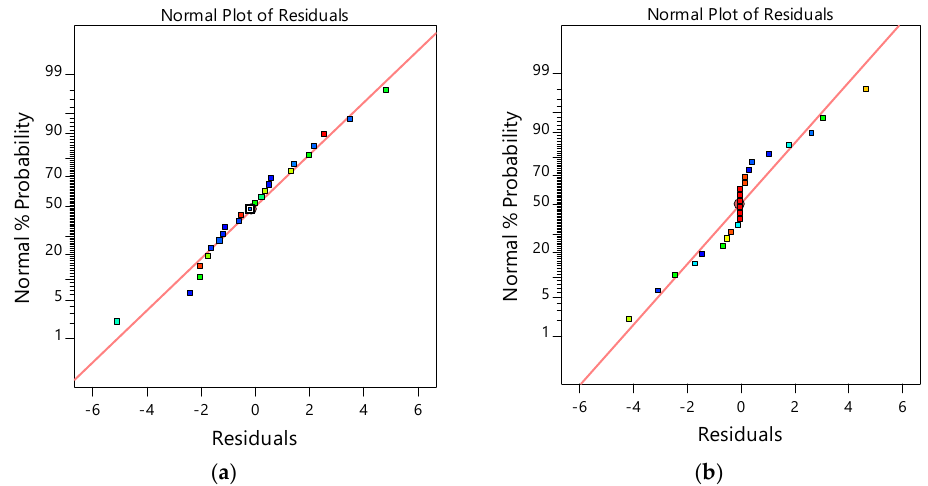
Figure 6. Normal probability plots of residuals for ( a ) CBZ removal and ( b ) phosphate